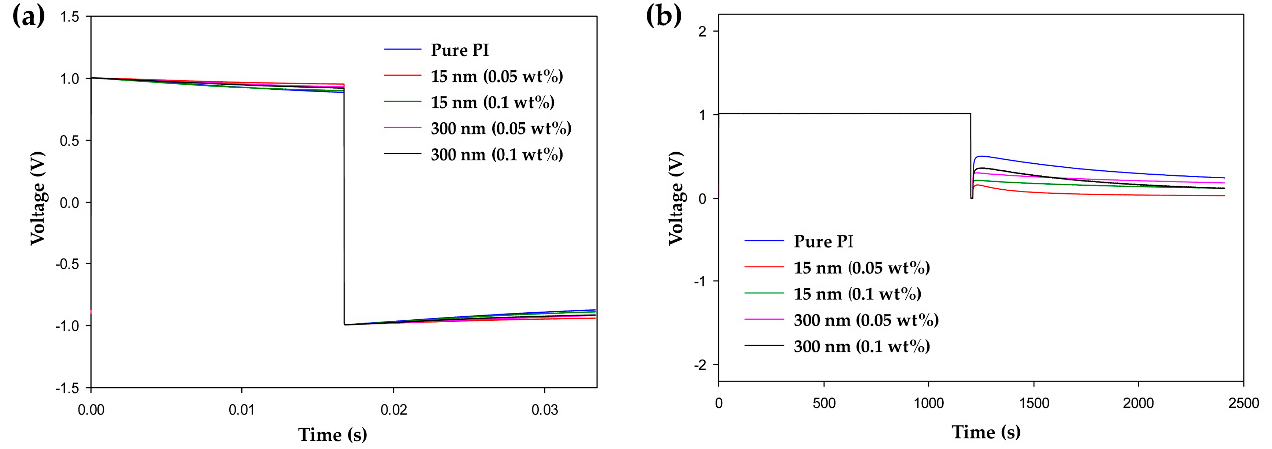
Figure 7. ( a ) Voltage holding ratio (VHR) curves and ( b ) residual direct current (RDC) curves of the LC cells fabricated using pure polyimide and hybrid polyimide alignment layers.